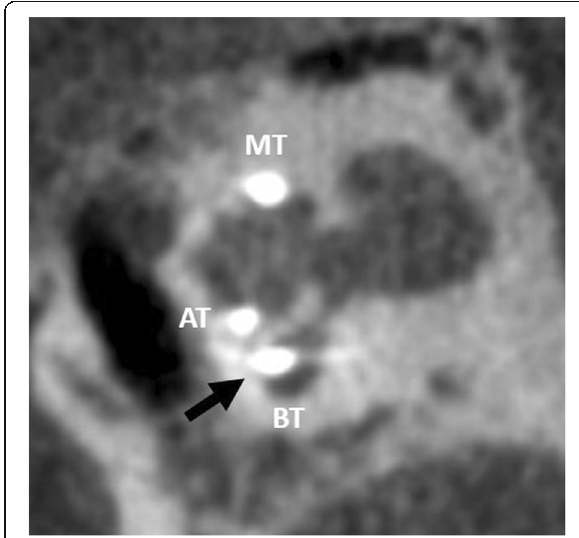
Fig. 24 A 70-year-old female patient, with an electrode placed in the scala vestibuli. CBCT paracoronal image shows an electrode array located in the scala vestibuli (upper segment) of the cochlear duct (black arrow). BT – basal turn. MT – middle turn. AT – apical